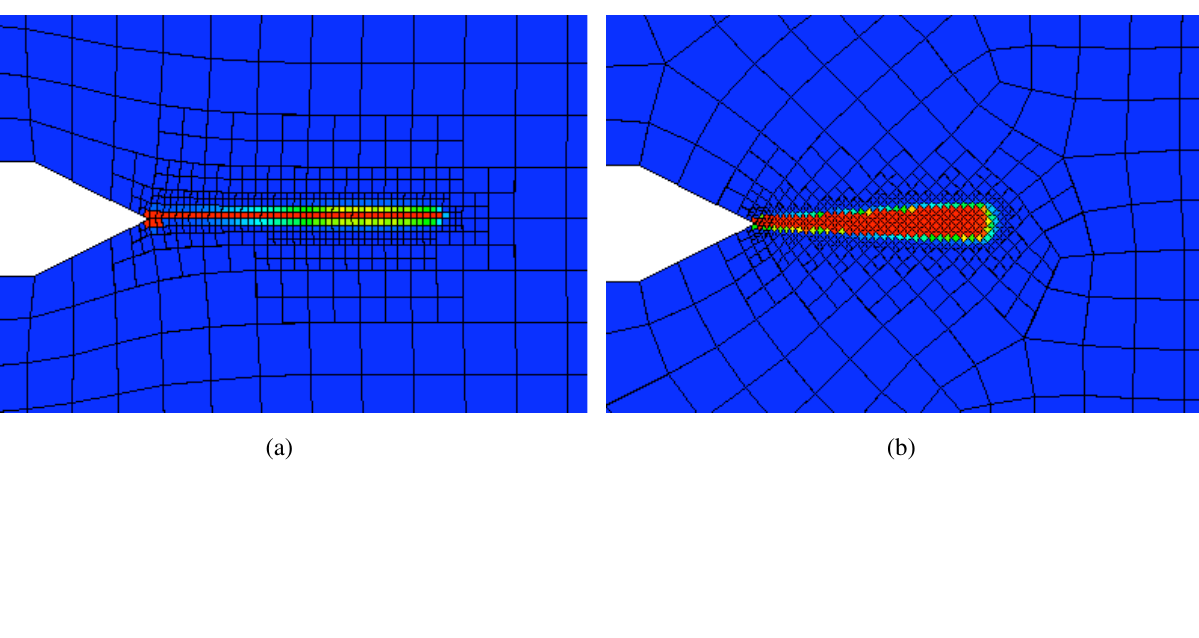
Figure 11 . Zoom-in of the damage solutions in Figures 10(a) and 10(b), respectively, showing the damage field solution produced by the damage-based refinement algorithm. The extent to which the damage is localized is clearly visible, and, for this first attempt, is considered thus far to be sucessful.